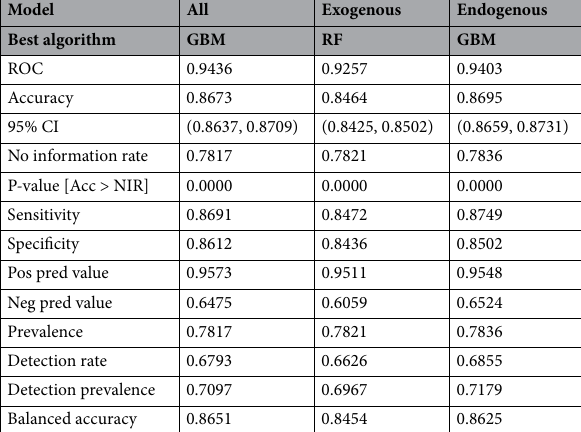
Table 5. Accuracy performance indicators for European universities’ co-publication prediction in Life Sciences. Three models considered: with all, with only exogenous, and with only endogenous features.